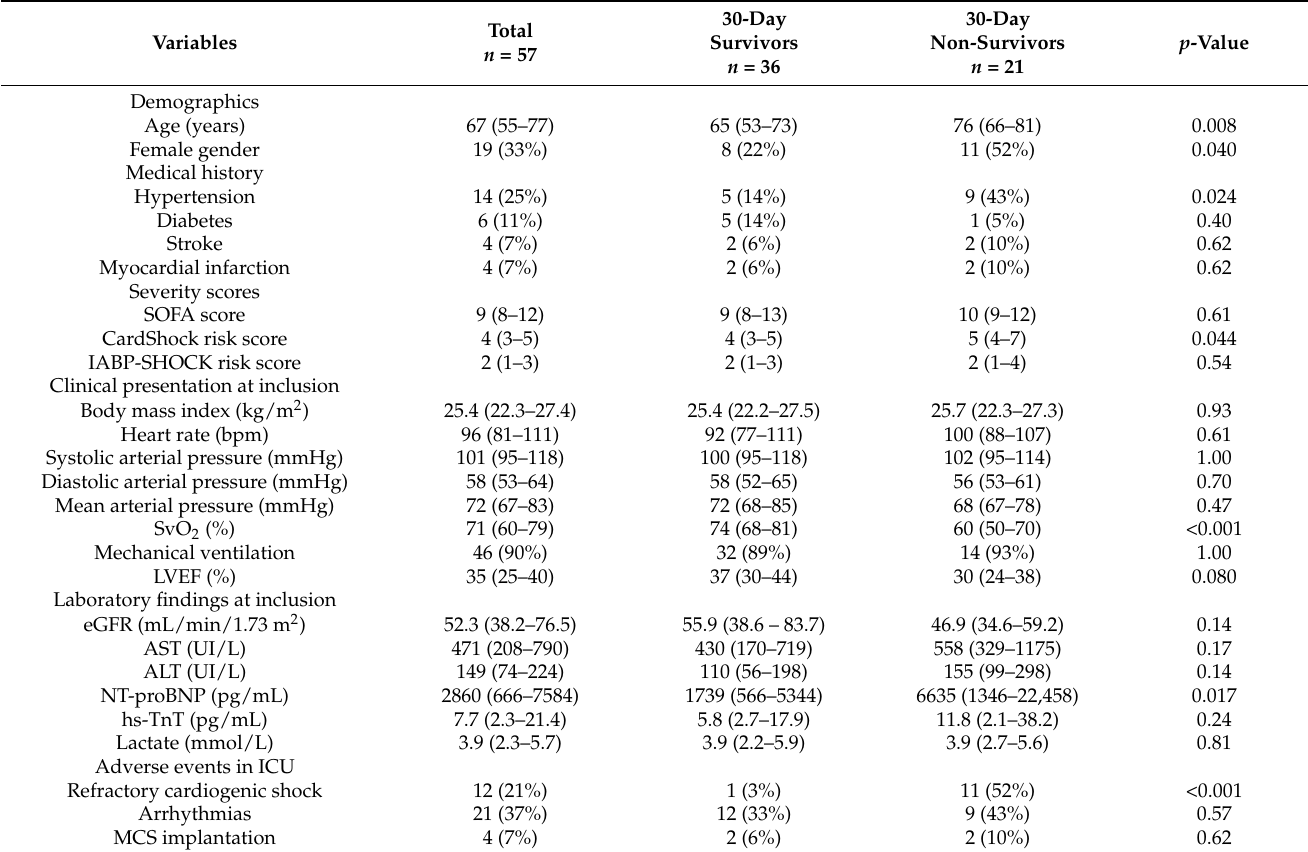
Table 1. Comparison of characteristics of cardiogenic shock patients between 30-day survivors and